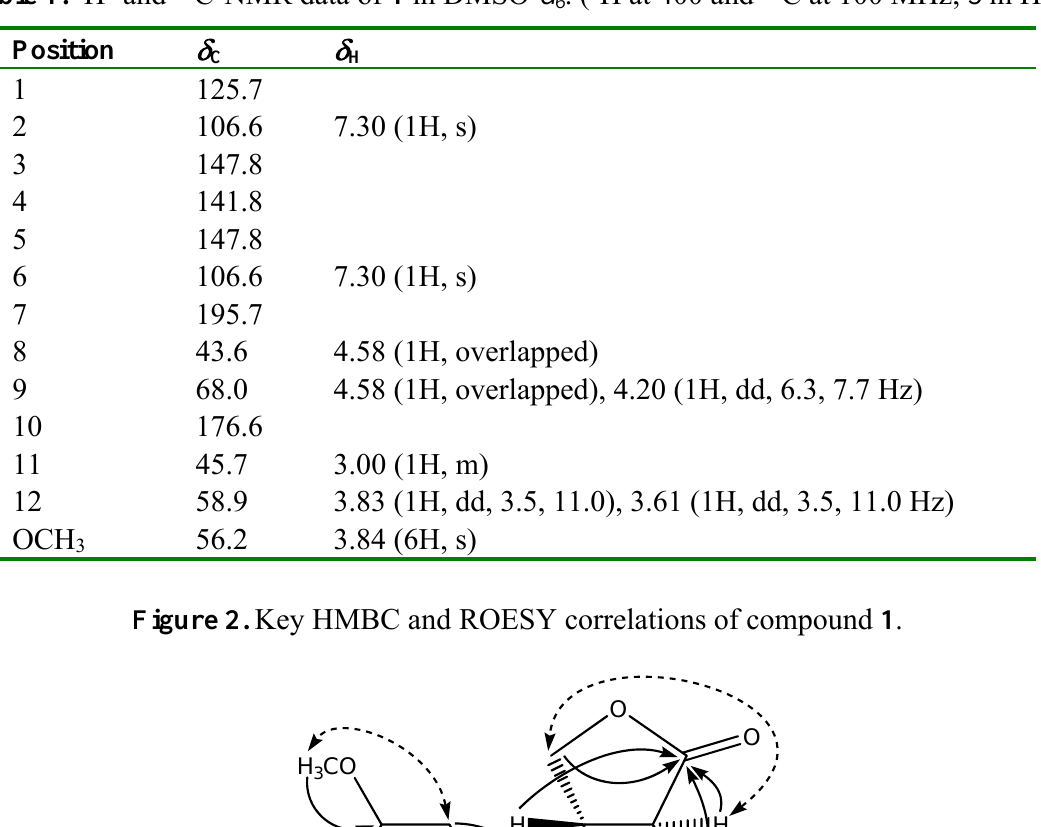
Table 1. 1 H- and 13 C-NMR data of 1 in DMSO- d